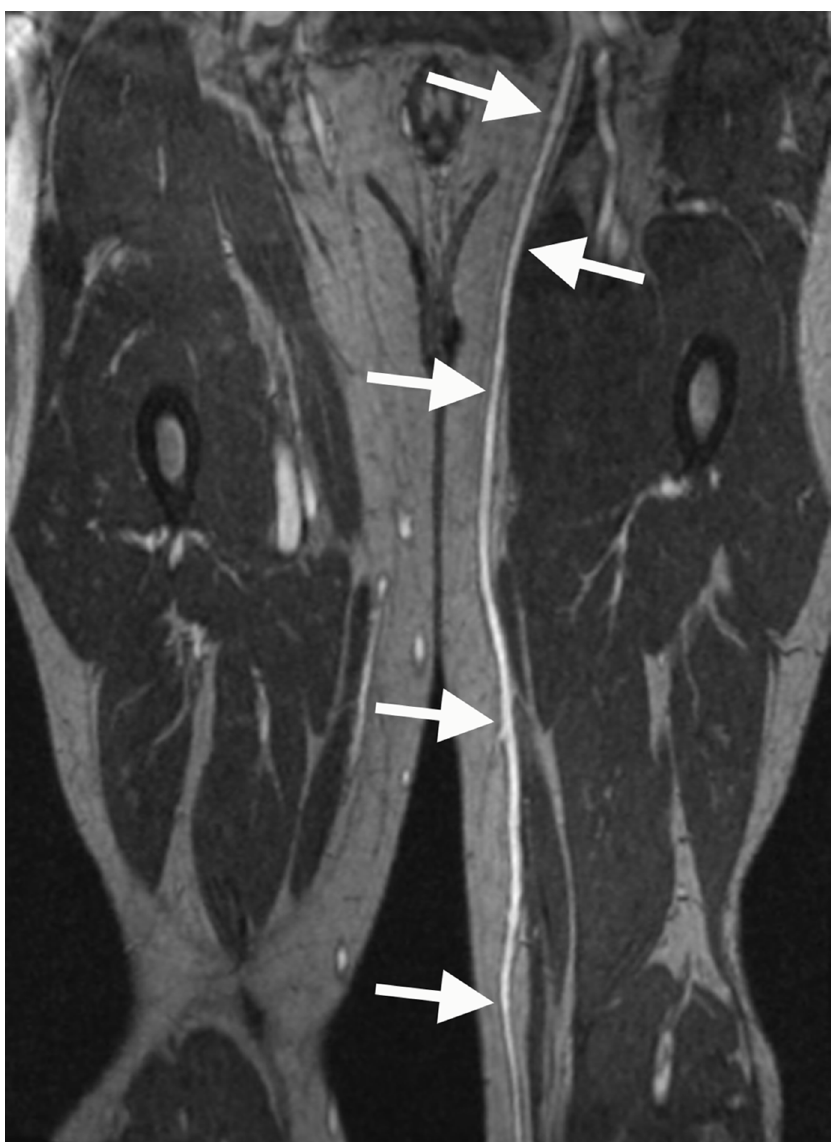
Figure 8. Multiplanar reformat of an MR-angiographic image of the great saphenous vein. The GSV displayed as a curved multiplanar reformat of high-spatial-resolution contrast-enhanced T1-weighted gradient-echo images during the steady-state of a 57 year old male patient suffering from PAOD stage III and thus being evaluated for bypass surgery.